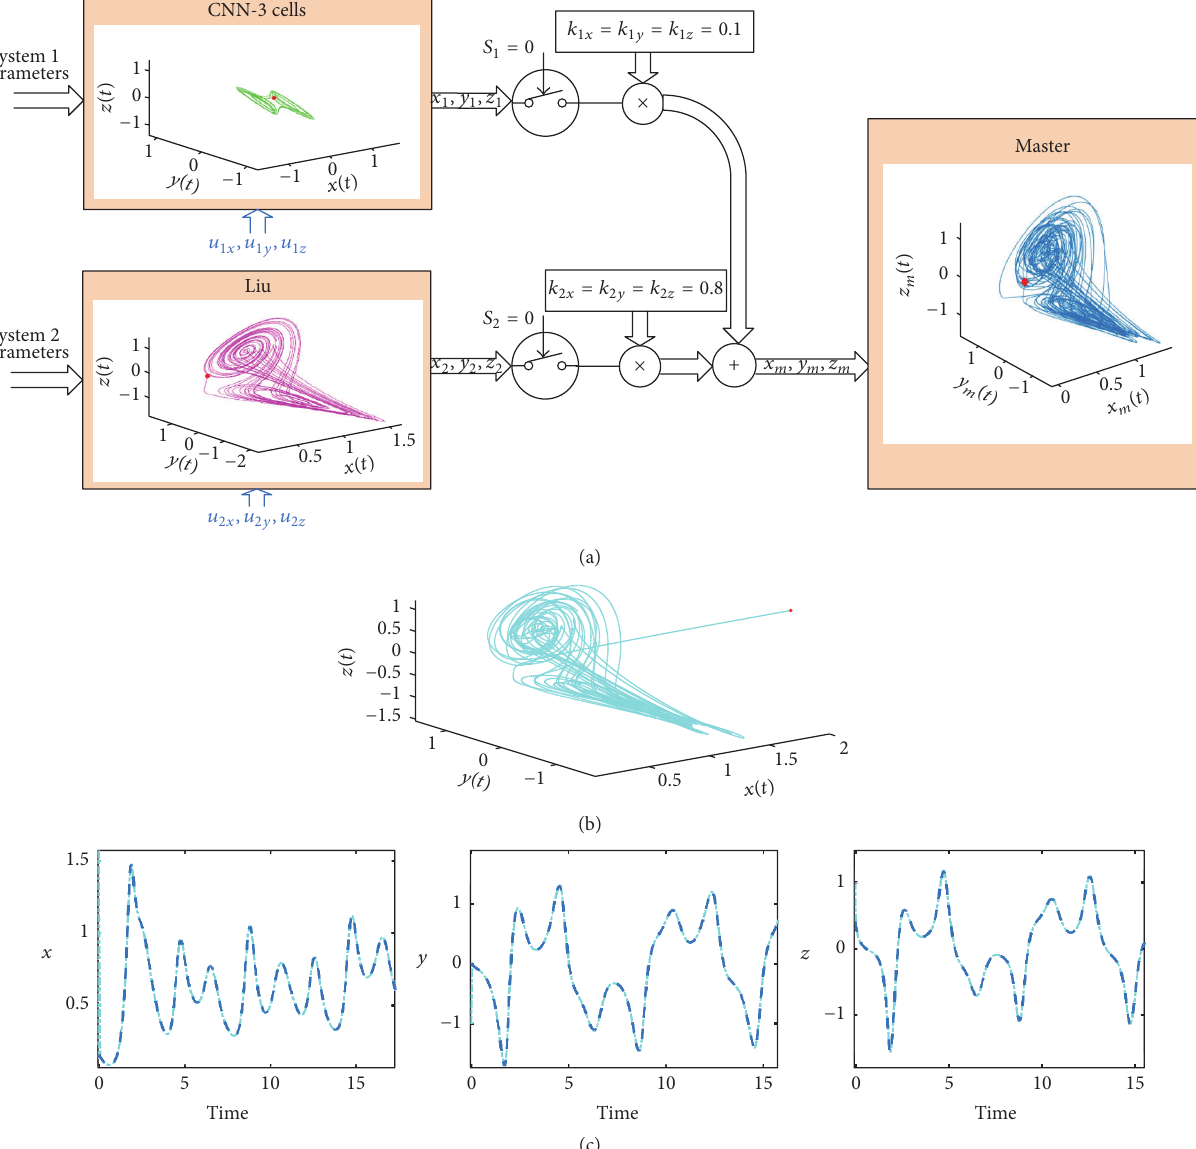
Figure 3: (a) Construction of the linear combination of CNN-3 cells and Liu systems with 𝑘 1𝑥 = 𝑘 1𝑦 = 𝑘 1𝑧 = 0.1 and 𝑘 2𝑥 = 𝑘 2𝑦 = 𝑘 2𝑧 = 0.8 , (b) attractor of the slave system successfully synchronized, and (c) time series of both master and slave systems successfully